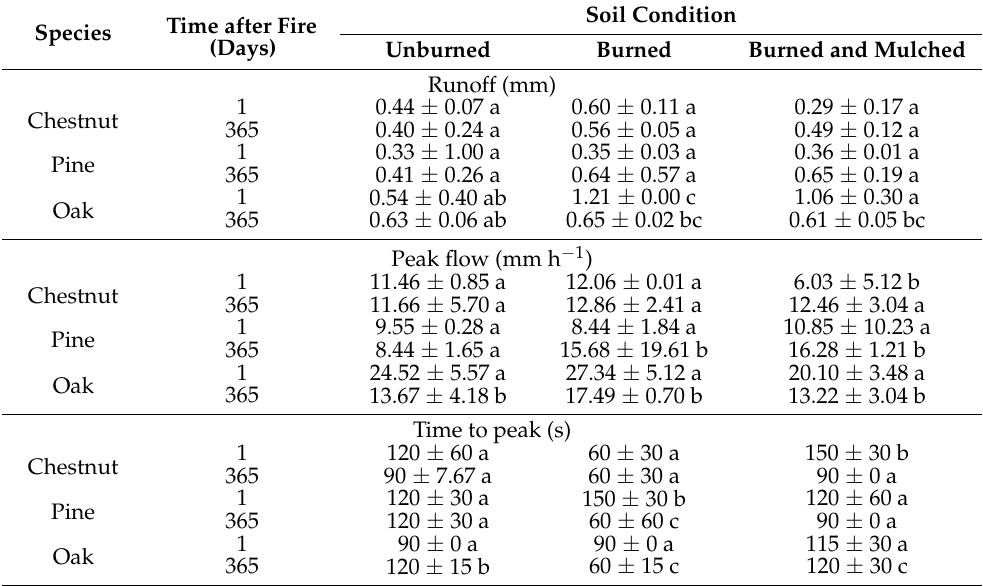
Note: different lowercase letters indicate significant differences in the interaction between soil conditions and time after fire, respectively, after Tukey’s test ( p <